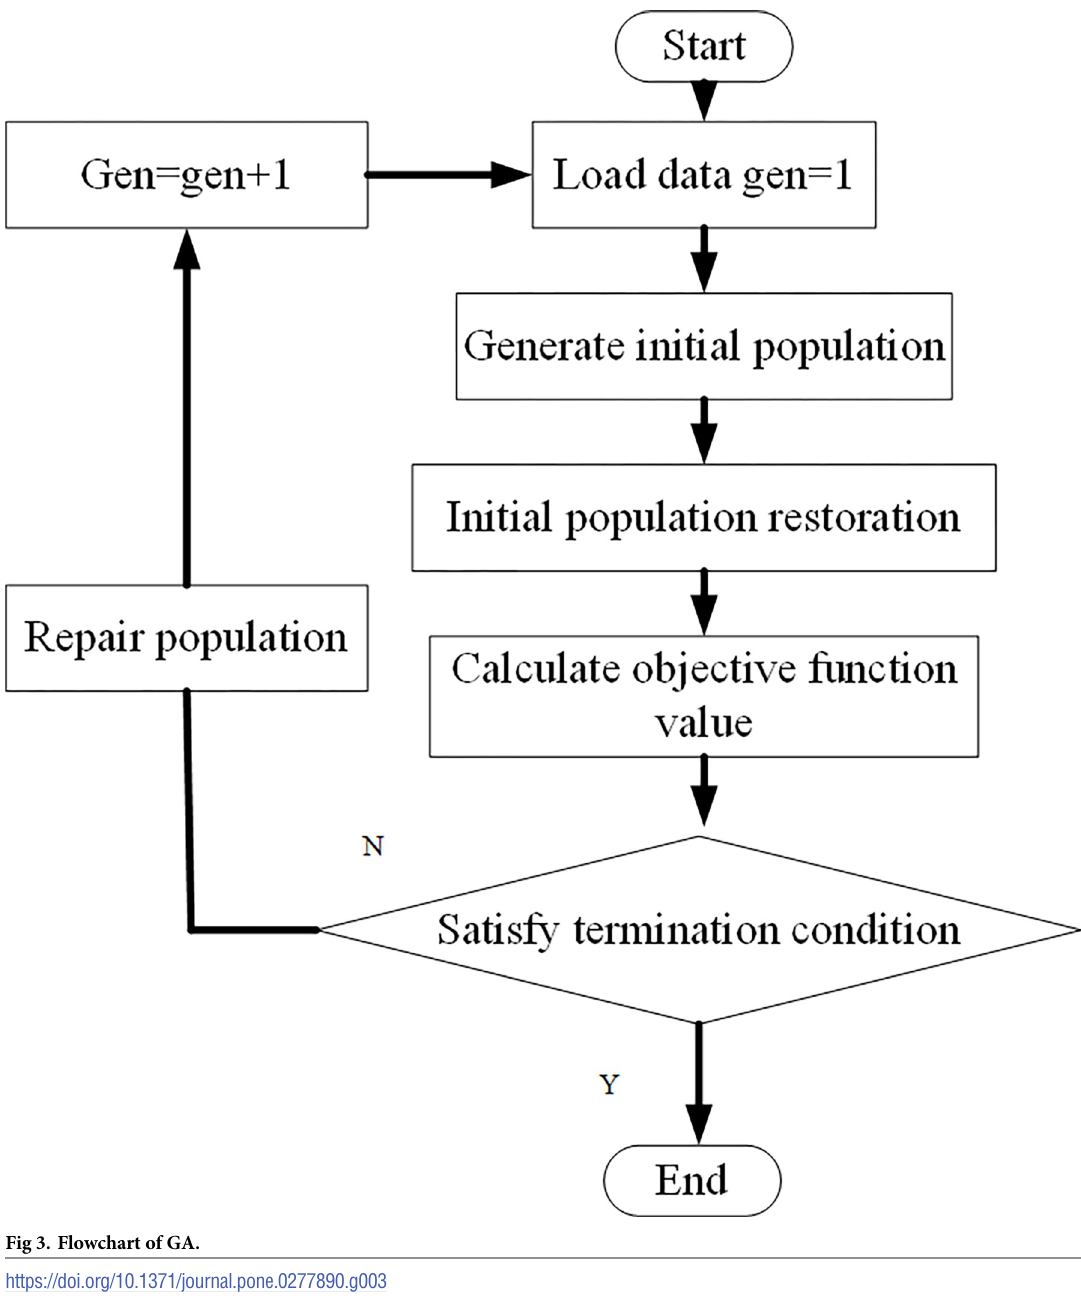
Fig 3. Flowchart of